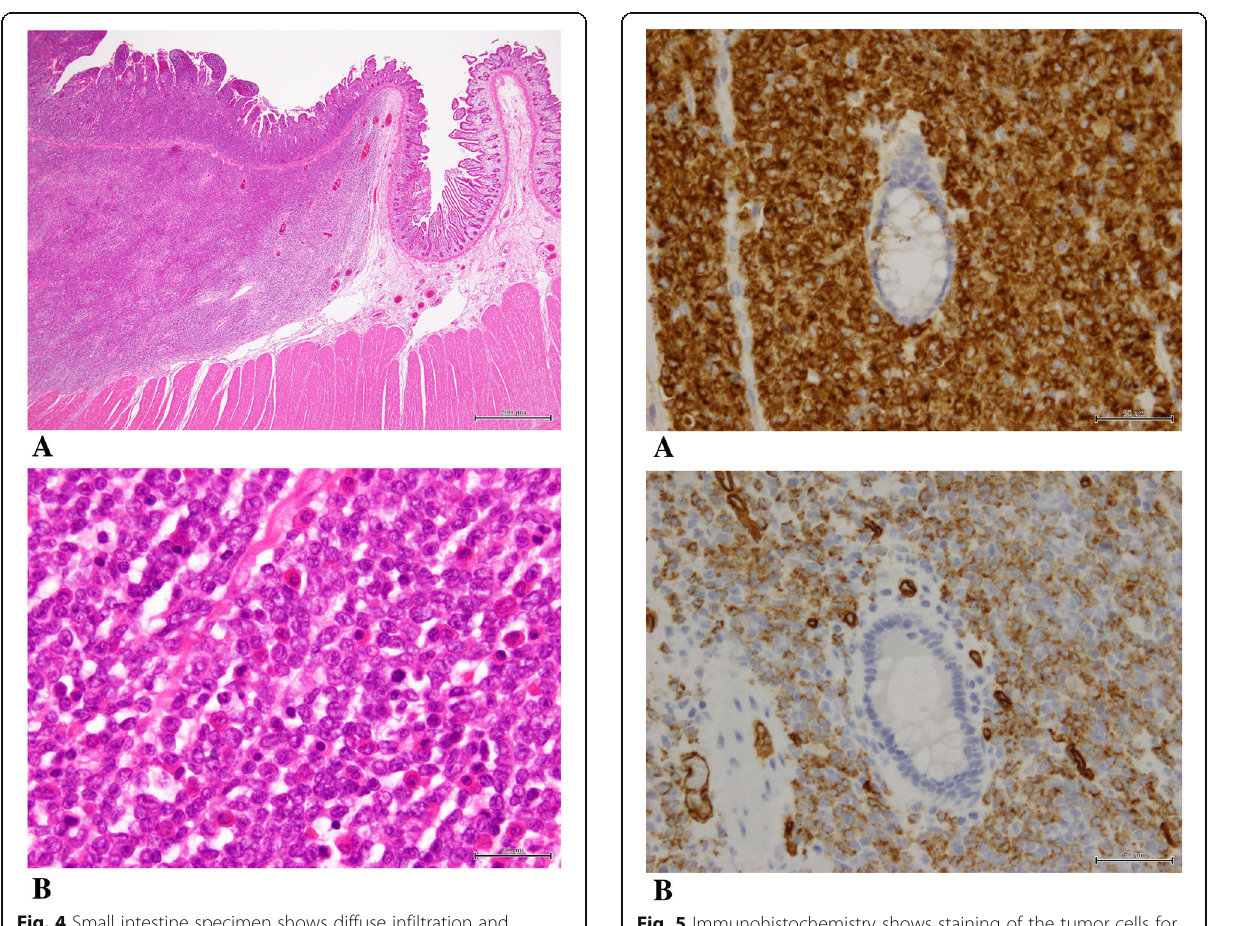
expansion of immature, atypical cells without tissue destruction (HE; a × 20, b × 200)